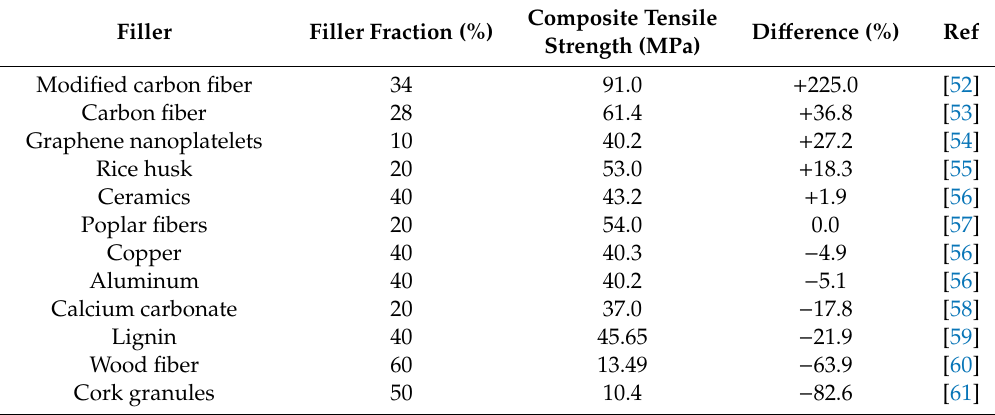
Table 2. The modification approaches on the biodegradable of